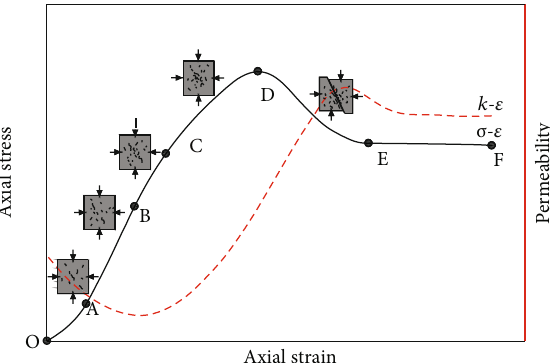
Figure 5: The relationships between stress, permeability, and strain in these sandstone